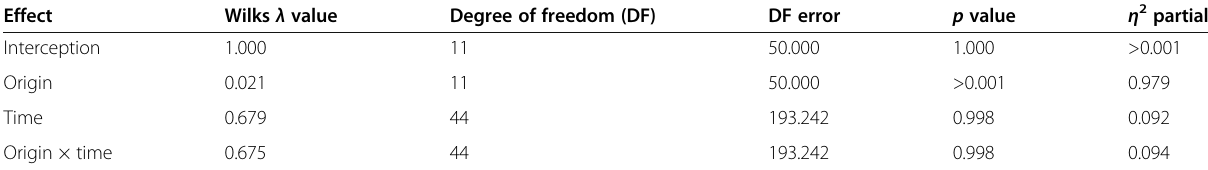
Table 6 Main effects of origin, time, and the interaction between both (origin × time) on macro- and micronutrients obtained by multivariate analysis of variance (MANOVA)